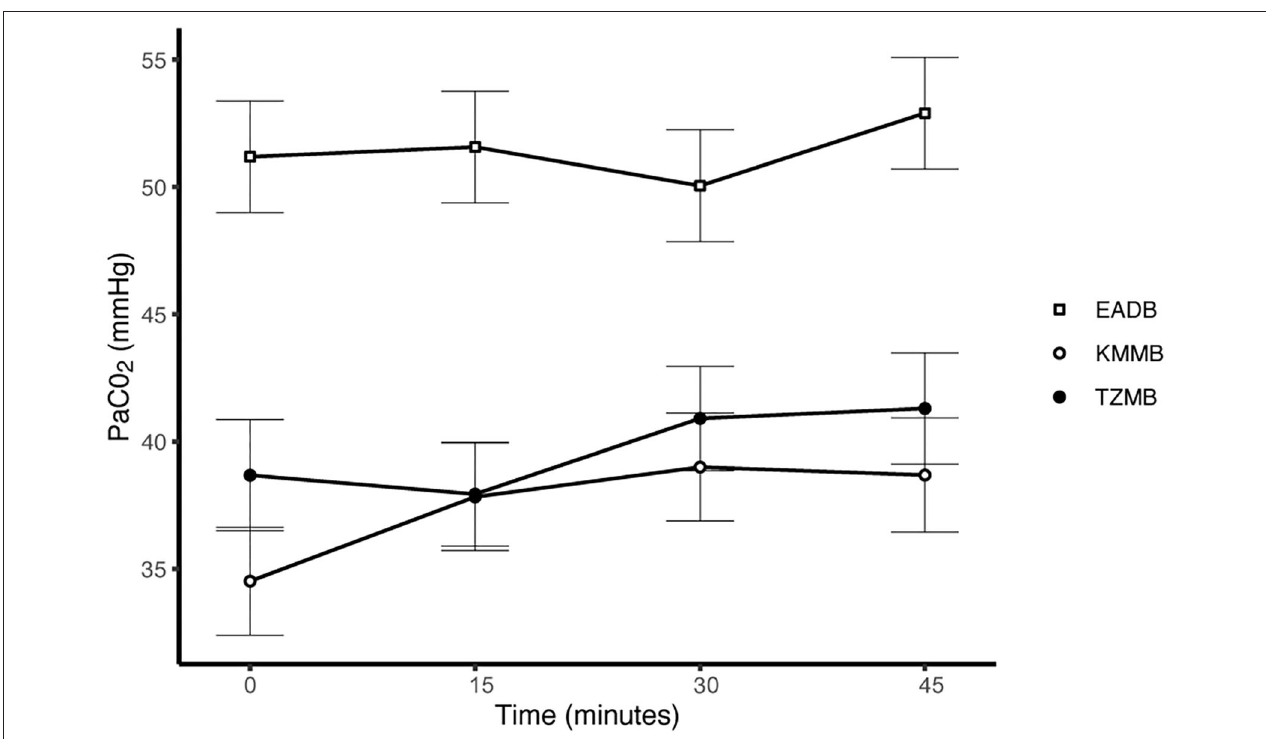
FIGURE 3 | Illustration of partial arterial pressure of carbon dioxide (PaCO 2 ) over time. Values at each timepoint are the means for treatment group 1 (KMMB), treatment group 2 (TZMB) and the control group (EADB) ± standard error (error